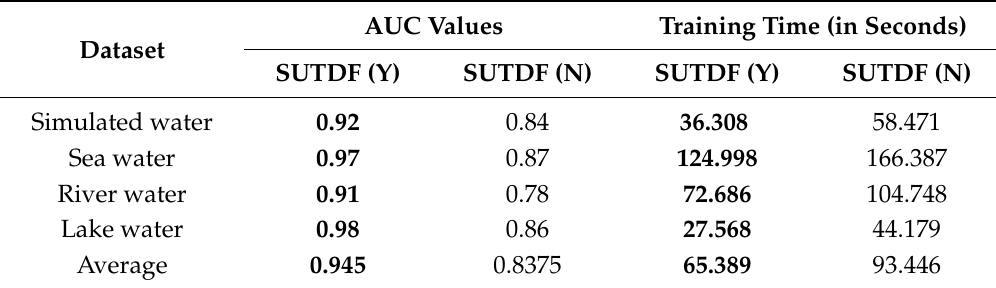
Table 4. The AUC values and training time for effectiveness evaluation of depth values